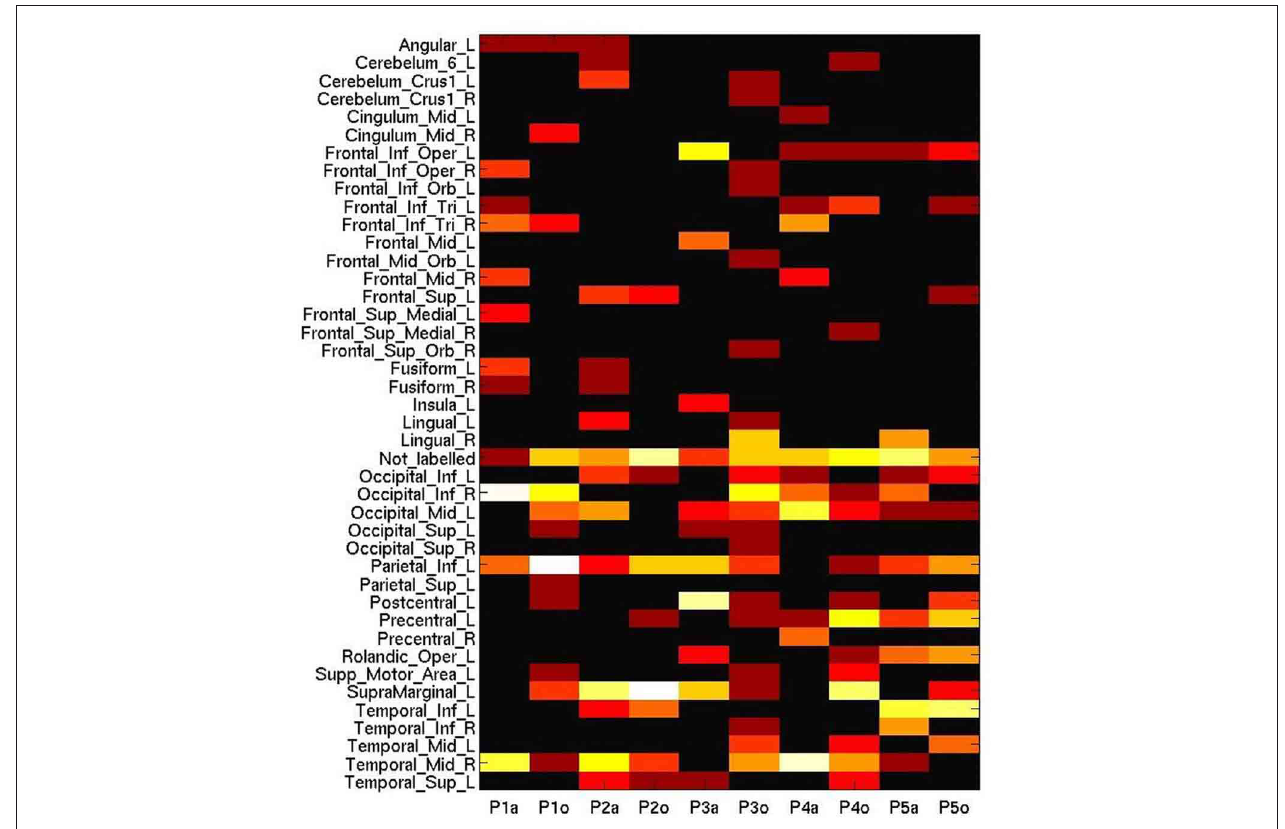
FIGURE 6 | Number of most informative voxels extracted by anatomical area (AAL brain atlas), ranging from 0 (black) to 20 (white), on a log-adjusted scale. Columns represent participant numbers, and stimulus modality (“a”, auditory; “o”, orthographic).